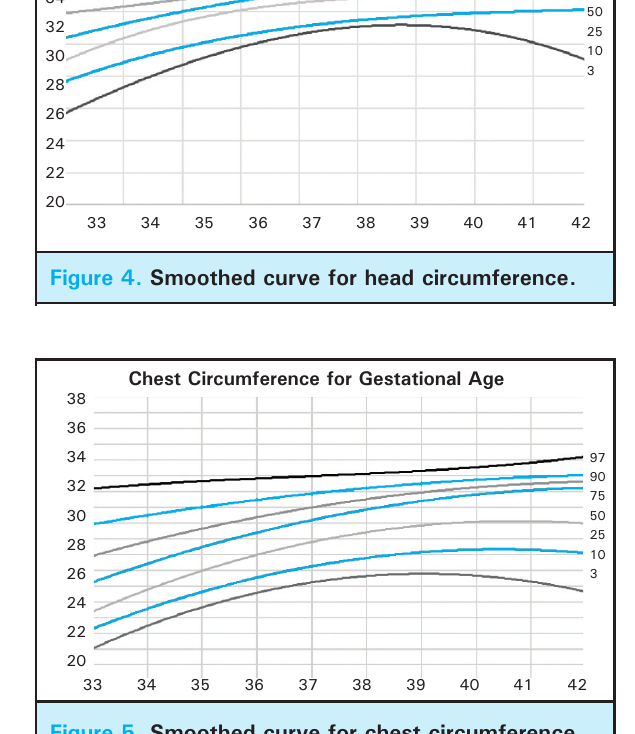
(Table 1). Smoothed curves of 3 rd , 10 th , 25 th , 50 th , 75 th